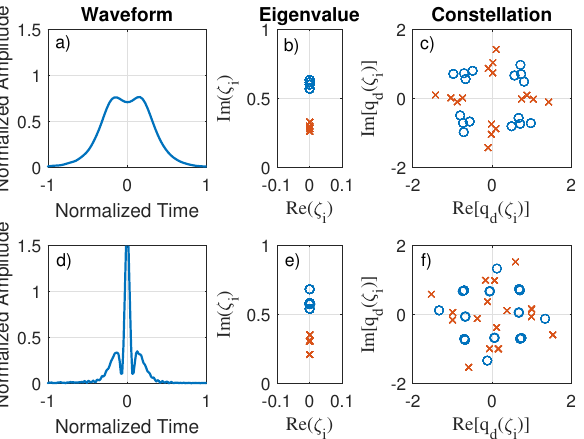
Figure 12. Simulation results with 1600 km of propagation distance and − 0.25 dBm of launch power. The system includes only fiber losses and lumped gain from EDFAs. ( a – c ) Results with symbol period equal to T S1 . ( d – f ) Results with symbol period equal to T S2 . ( a , d ) Received waveform of one symbol of the sequence. ( b , e ) Received eigenvalues. ( c , f ) Normalized received spectral function constellations, q d ( ζ 1 ) (blue circles) and q d ( ζ 2 ) (red